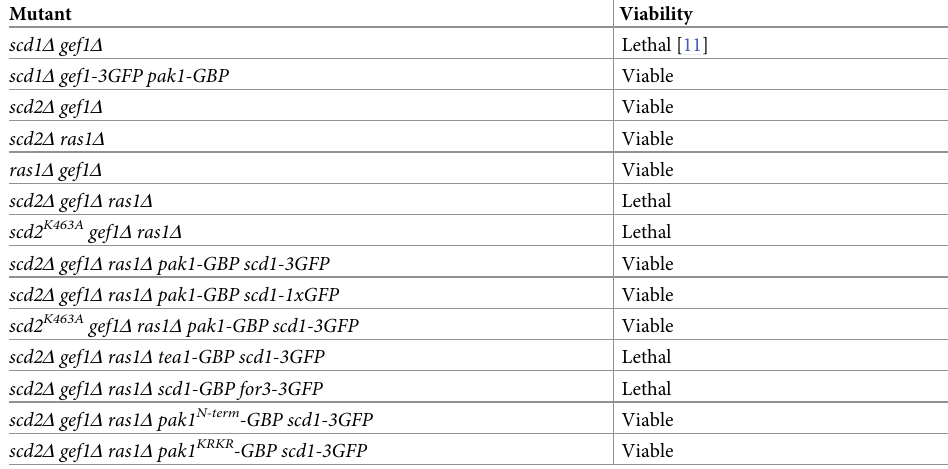
Table 1. Genetic interaction of scd1 Δ , scd2 Δ , ras1 Δ , and gef1 Δ . Viability or lethality of indicated genotypes was assessed by tetrad dissection of crosses described in S1 Table.